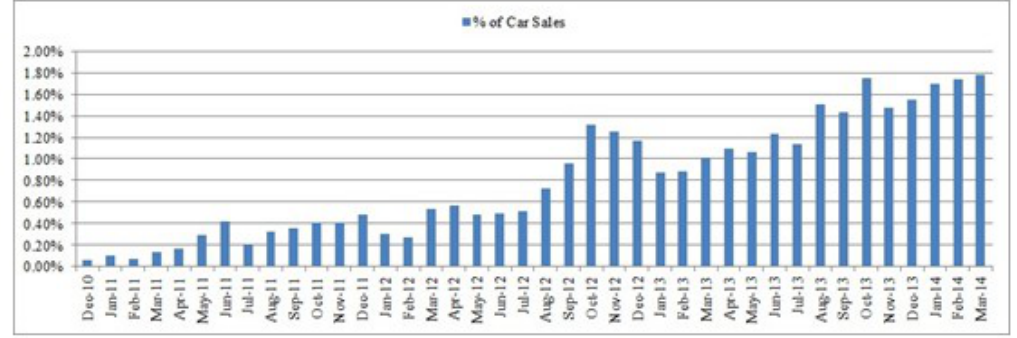
Figure 5. Percentage of EVs monthly sales to Car monthly sales from Dec. 2010 to Mar.